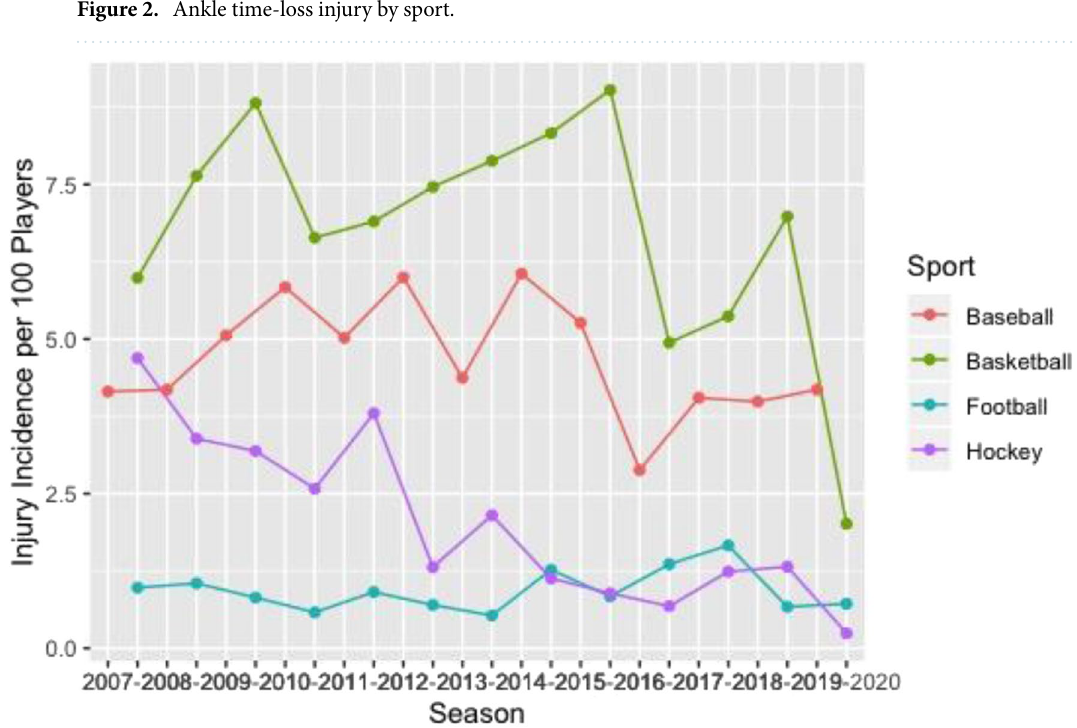
Figure 3. Back time-loss injury by